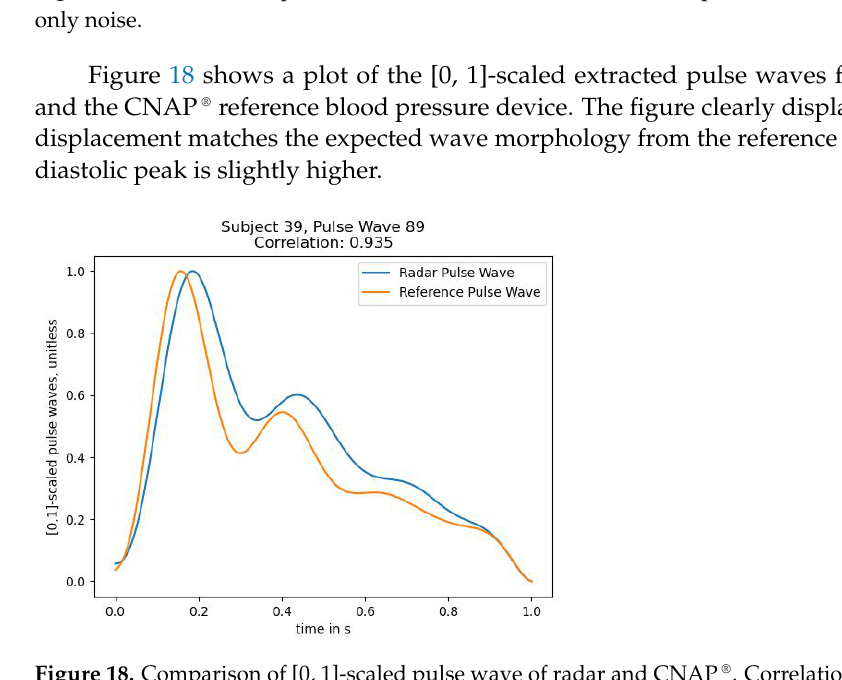
Figure 18. Comparison of [0, 1]-scaled pulse wave of radar and CNAP ® . Correlation value shows the correlation between this wave and the reference pulse wave, not the CNAP ®